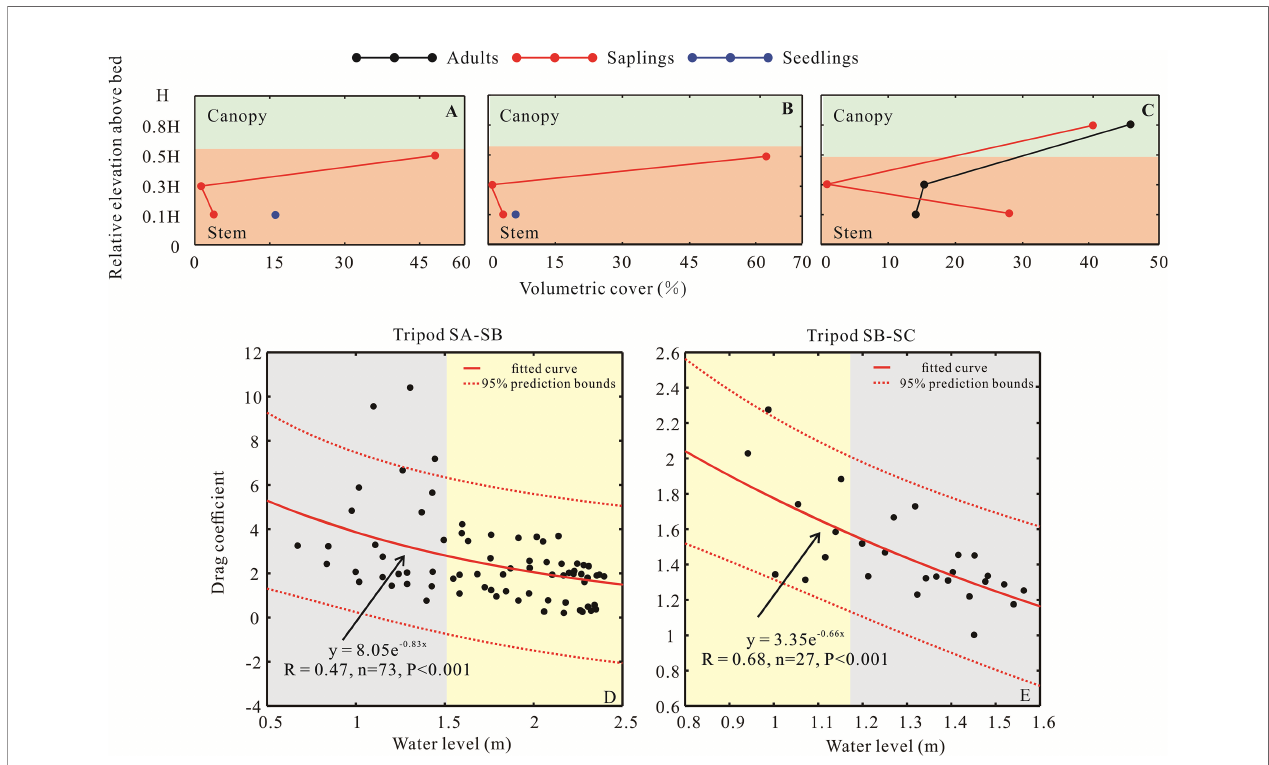
FIGURE 8 | Volumetric cover in three measurement plots (A – C) , corresponding to the three hydrodynamic tripods. The relationship between the volumetric cover and relative elevation above the bed is described as follows: a) black and red dots and lines refer to the adults and saplings at the SA station; b) red dots and lines and blue dots refer to the saplings and seedlings at the SB station; and c) red dots and lines and blue dots refer to the saplings and seedlings at the SC station. The relationship between the water level and drag coef fi cient is shown for (D) tripods SA-SB and (E) tripods SB-SC. The gray shadow is the period of the high drag effect, and the yellow shadow is the period of the low drag